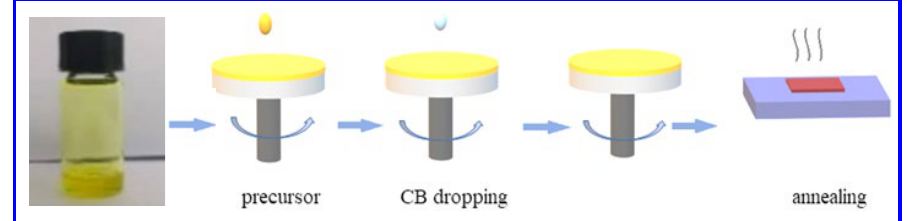
Figure 2. Fabrication process for (PEA) 2 (MA) 2 Pb 3 I 10 perovskite film.